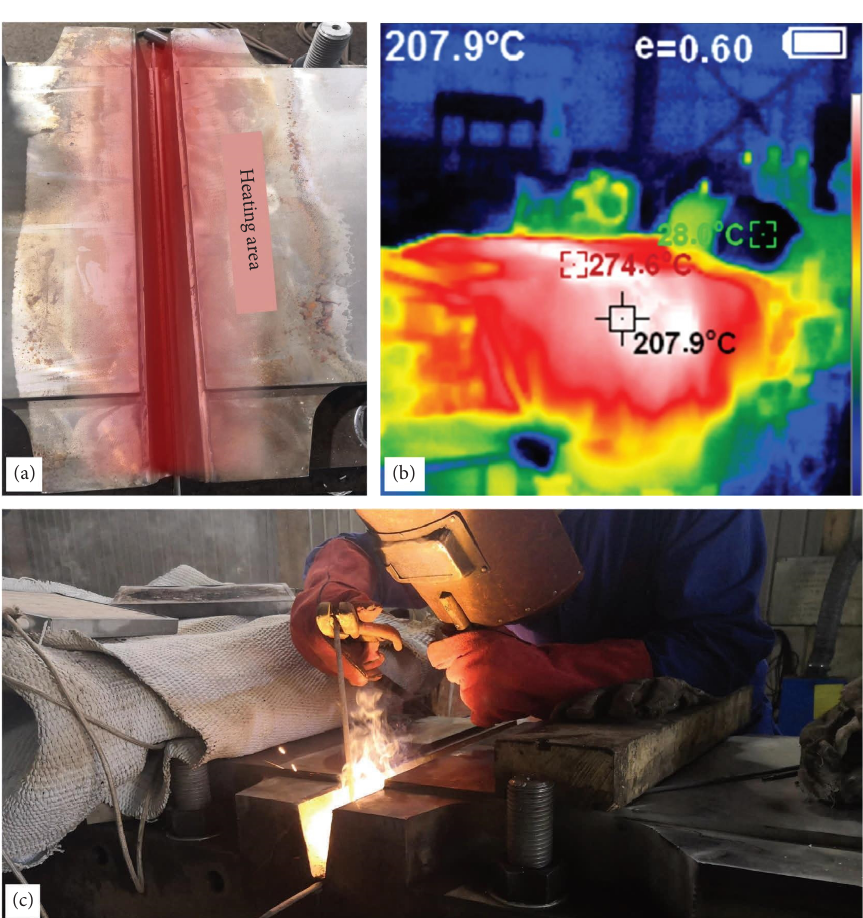
Figure 5: Preheating and welding of the antenna’s azimuth track. (a) Heated and insulated welding area. (b) Acquisition of temperature data for welding. (c) Welding process of the antenna’s azimuth track.